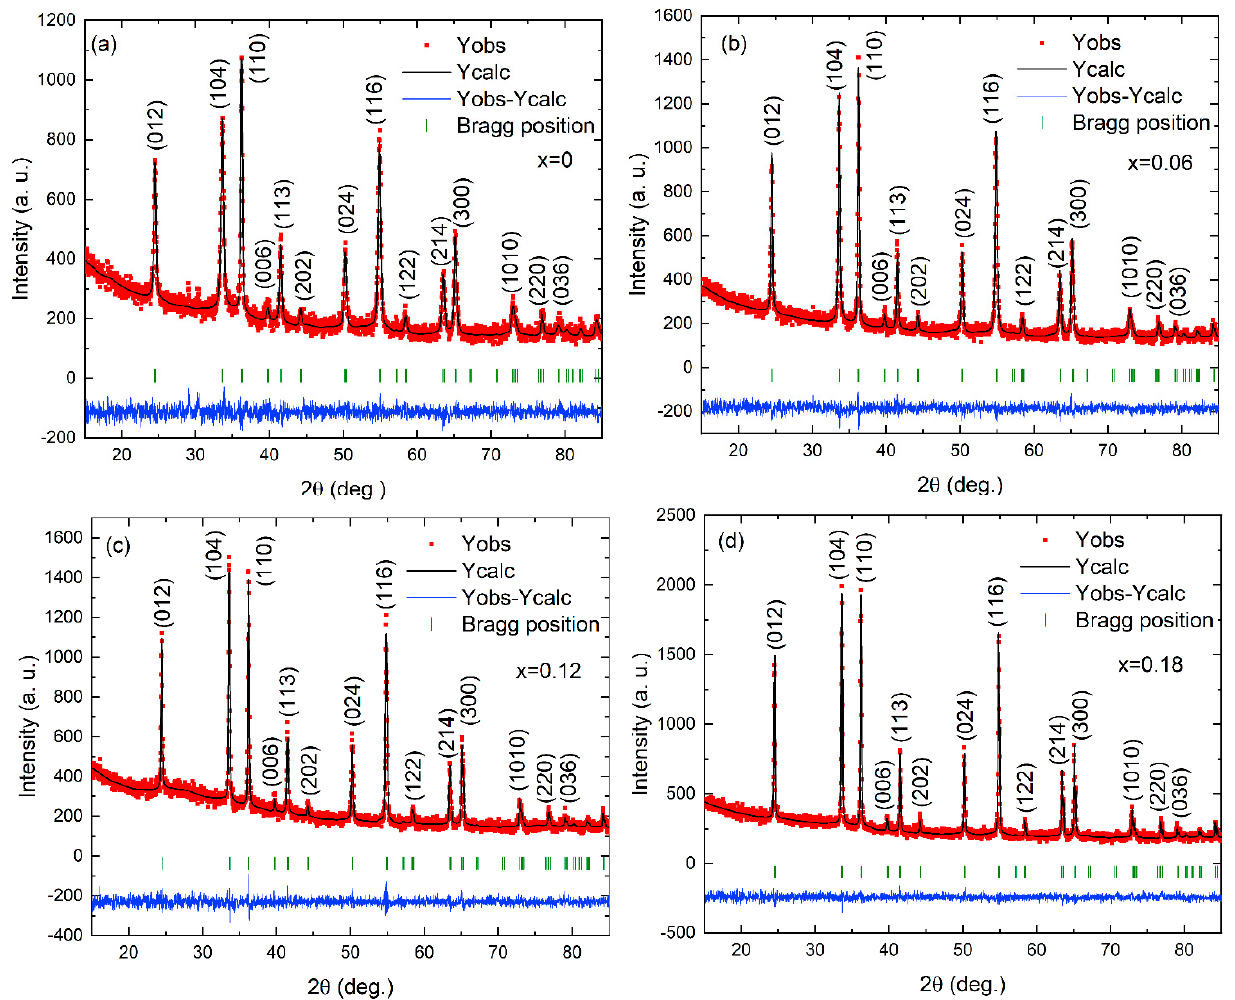
Figure 1. Observed (red), calculated (black), and differential patterns of Rietveld refinements of X-ray diffraction for Cr 2 − x Fe x O 3 nanoparticles: ( a ) x = 0, ( b ) x = 0.06, ( c ) x = 0.12, and ( d ) x = 0.18. The red square symbols and the black line denote the observed and calculated intensities, respectively. Short vertical lines (green) indicate the positions of the possible Bragg reflections of the rhombohedral structure. The difference between the observed and calculated profiles (blue) is plotted at the bottom.